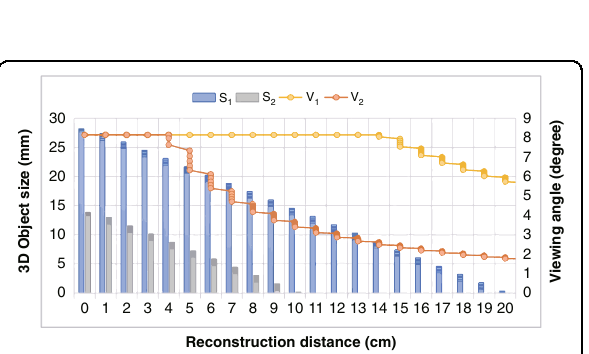
Fig. 10 Performance comparison between the proposed large size holographic display method and the traditional